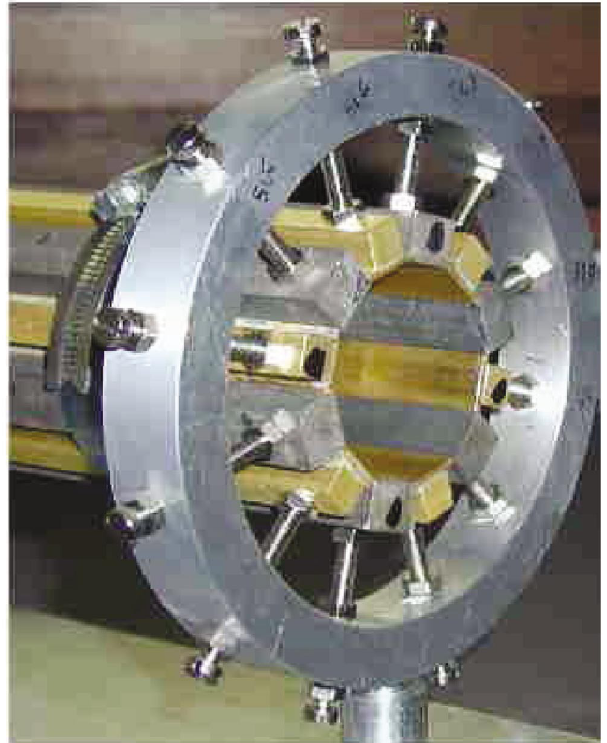
FIG. 8. (Color) Prototype used in the